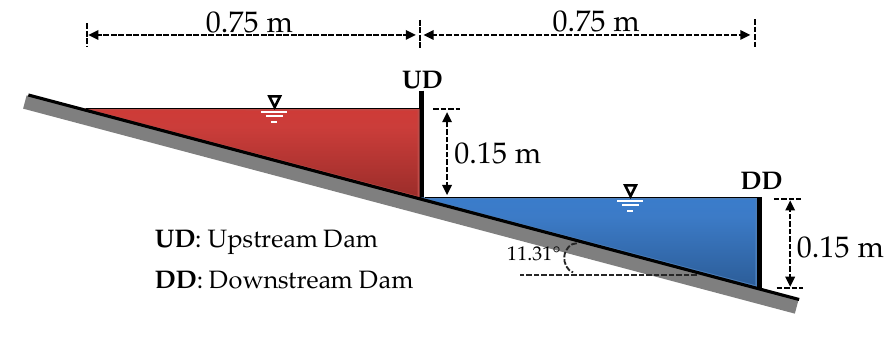
Figure 1. Test set-up.